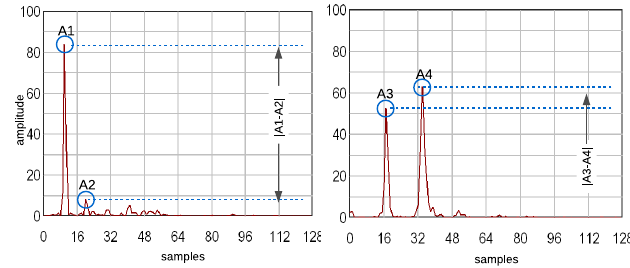
Figure 3. Example of bpm extraction and confidence level computation using FFT: (graph on the left) the difference between the highest peak amplitude ( A ) and the second highest peak 1 amplitude ( A ) normalised by the highest peak amplitude ( A ) 2 1 tends to 1; (graph on the right) the amplitudes are close, that is, the normalised difference tends to